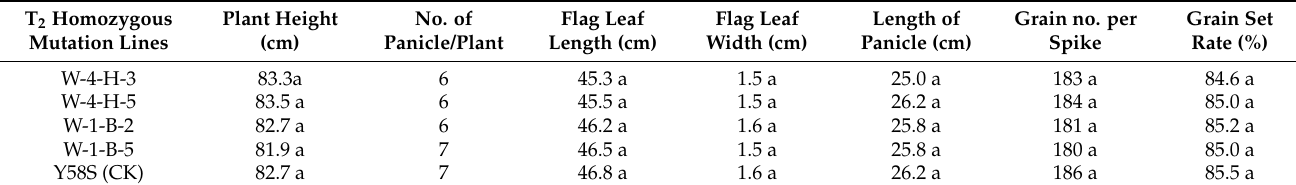
Table 5. Agronomic characters of wx-Y58S T-DNA-free T 2 homozygous mutants.